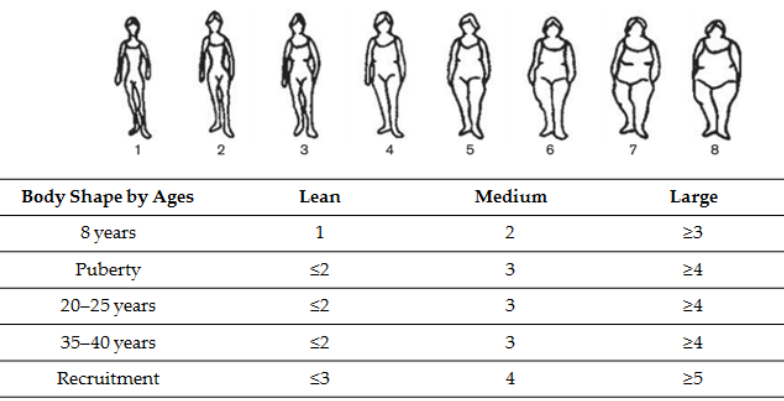
Figure 1. Classification of body shape at different ages, using Sørensen’s pictograms